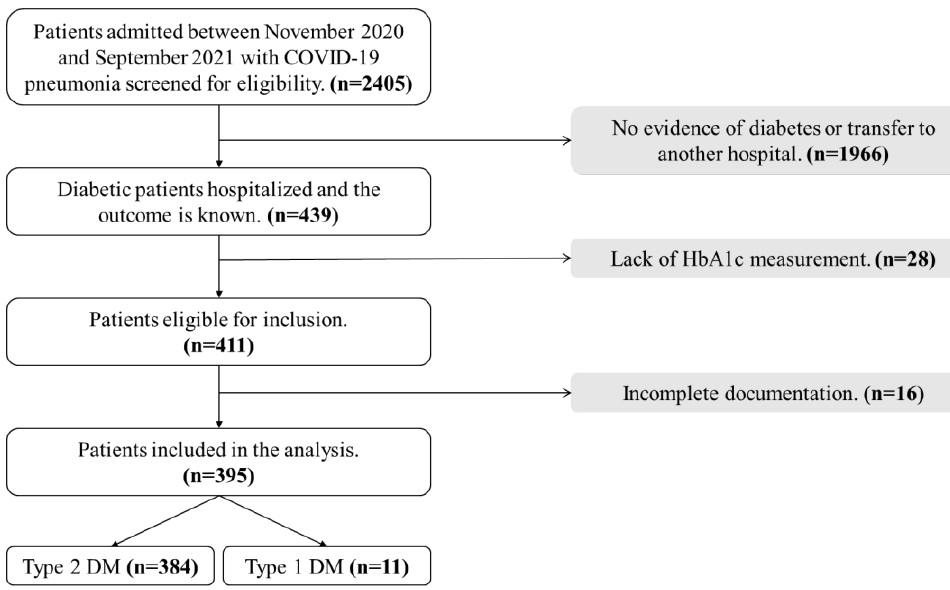
Figure 1. A flow chart demonstrating selection of the study cohort. Abbreviations: COVID-19, coronavirus disease 2019; DM, diabetes mellitus; HbA1c, glycated hemoglobin. The mean age of patients in our cohort was 59.4 ± 13.3 years and 50.1% of patients were males. The most prevalent comorbidity was hypertension (55.2%), followed by atherosclerotic cardiovascular disease (41.8%). Table 1 demonstrates the baseline demographic, clinical, and laboratory characteristics of the whole cohort and their profiles according to SHR tertiles. Patients had a median admission glucose of 12.2 mmol/L and a median HbA1c of 8.6%. Patients in the third SHR tertile tended to have a lower lymphocytic count, lower hemoglobin, and higher admission glucose compared to the other tertiles. Table 1. Demographics, comorbidities, and laboratory parameters for the patients according to SHR tertiles. Normal